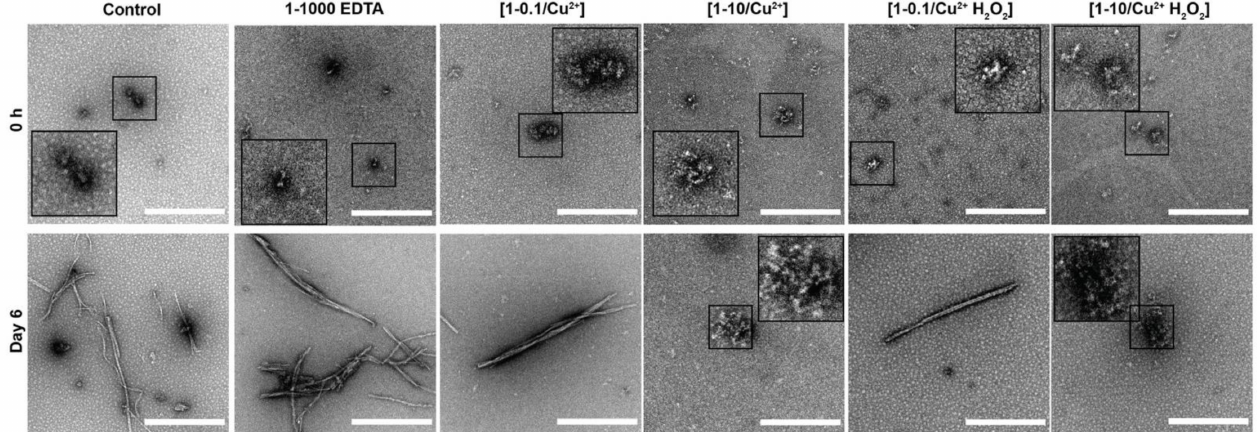
Figure 4. Freshly prepared control, [1-0.1/Cu 2+ ], [1-10/Cu 2+ ], [1-0.1/Cu 2+ H 2 O 2 ], [1-10/Cu 2+ H 2 O 2 ] and 1-1000 EDTA samples were incubated at 37 ◦ C/350 RPM. TEM imaging of all the samples at 0 h revealed small, round assemblies ( Top row ). At six days post-incubation, the control, [1-0.1/Cu 2+ ] and [1-0.1/Cu 2+ H 2 O 2 ] samples showed both short and long fibrils. The [1-10/Cu 2+ ] and [1-10/Cu 2+ H 2 O 2 ] samples showed mostly small and large amorphous assemblies. The 1-1000 EDTA samples revealed mature, twisted filaments. Scale bar, 500